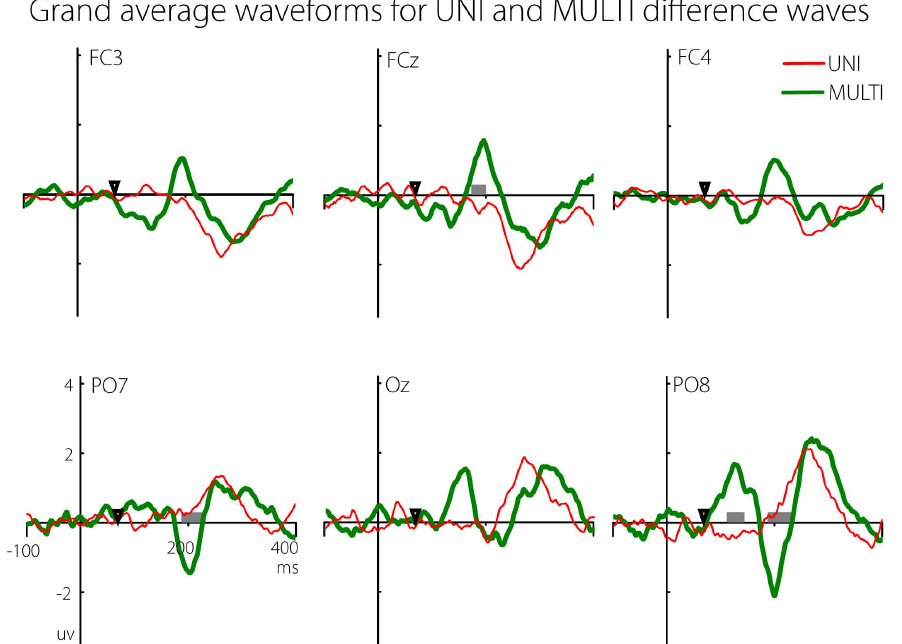
Figure 4. Grand averages for UNI (red) and MULTI (green) difference waves. Grey boxes show time points at which a permutation test indicated a significant difference between the waveforms. The x-axis represents time relative to the first flash. The time of the second flash (67 ms) is marked on the x-axis.